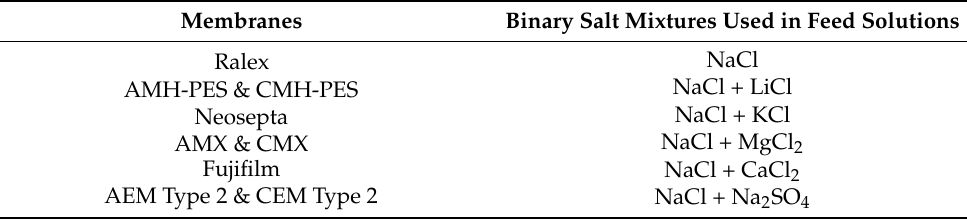
Table 5. Types of salt mixtures used for different membrane pairs.